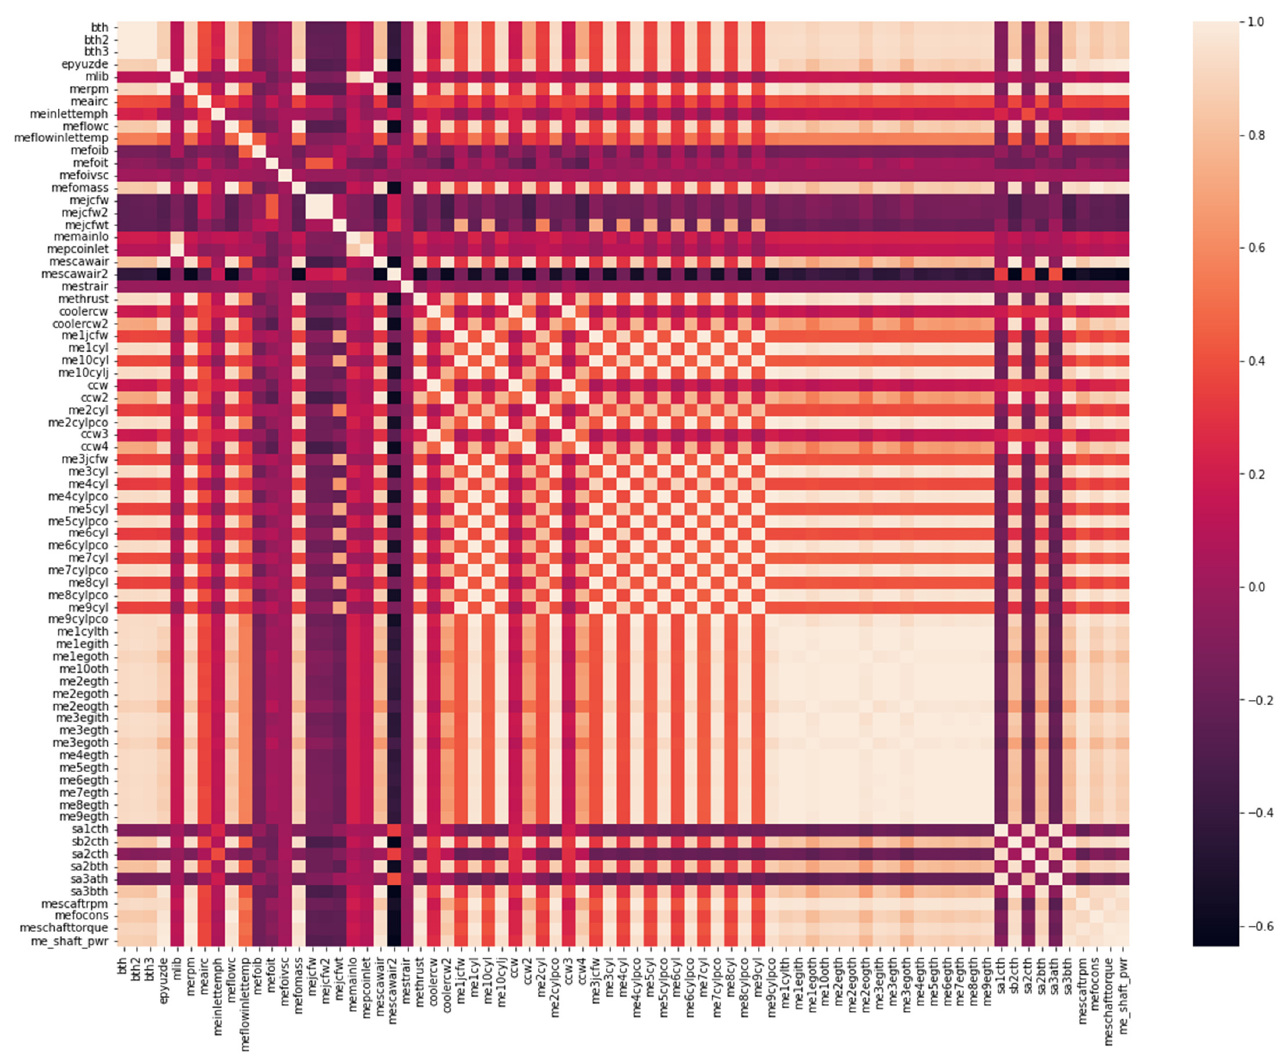
Figure 3. Pearson correlation matrix of the dataset.